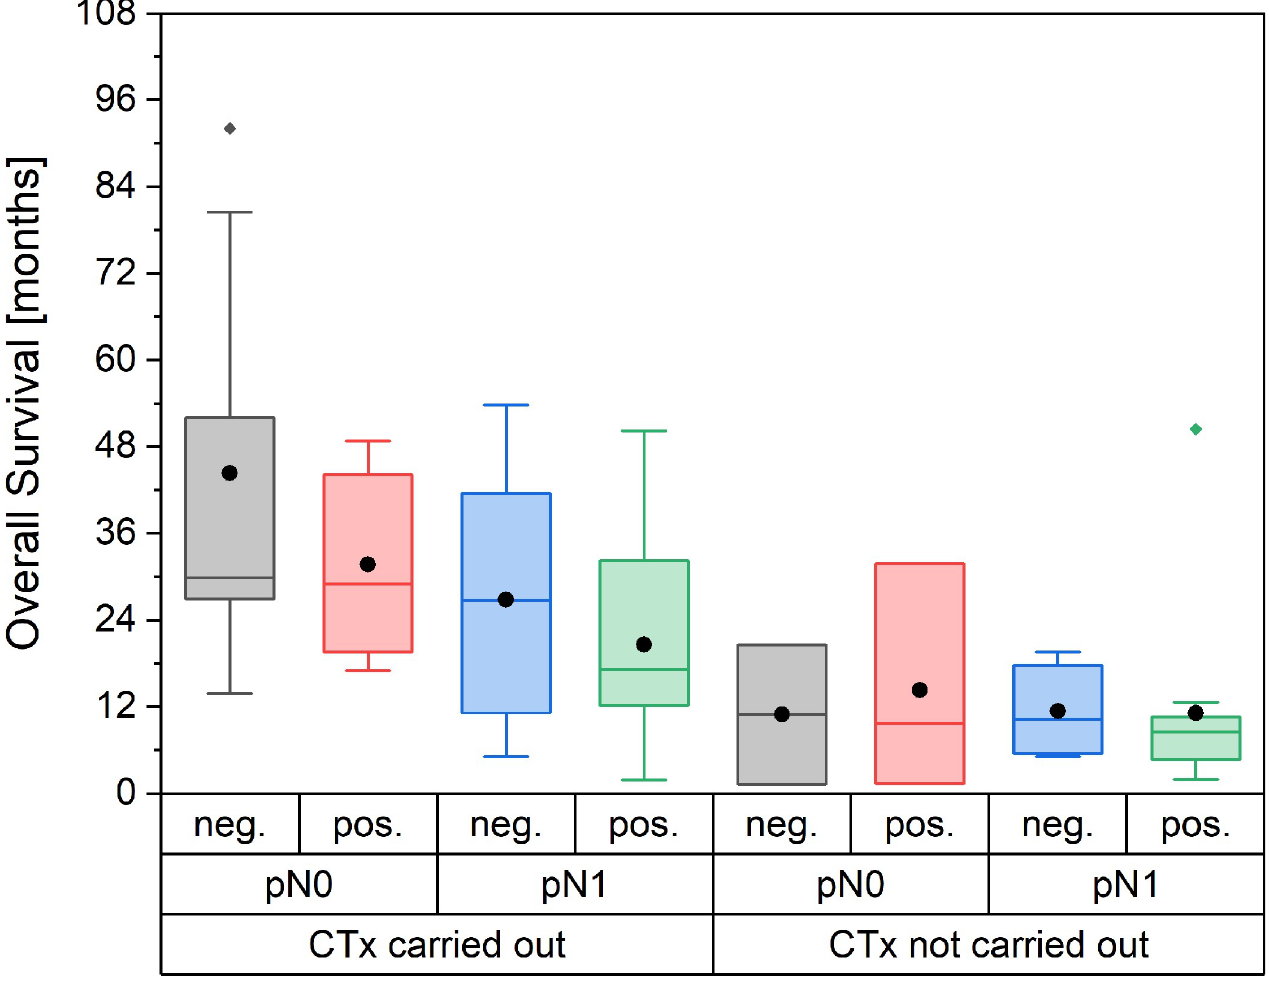
Fig 7. OS as a function of CTx, PN status, and CRM